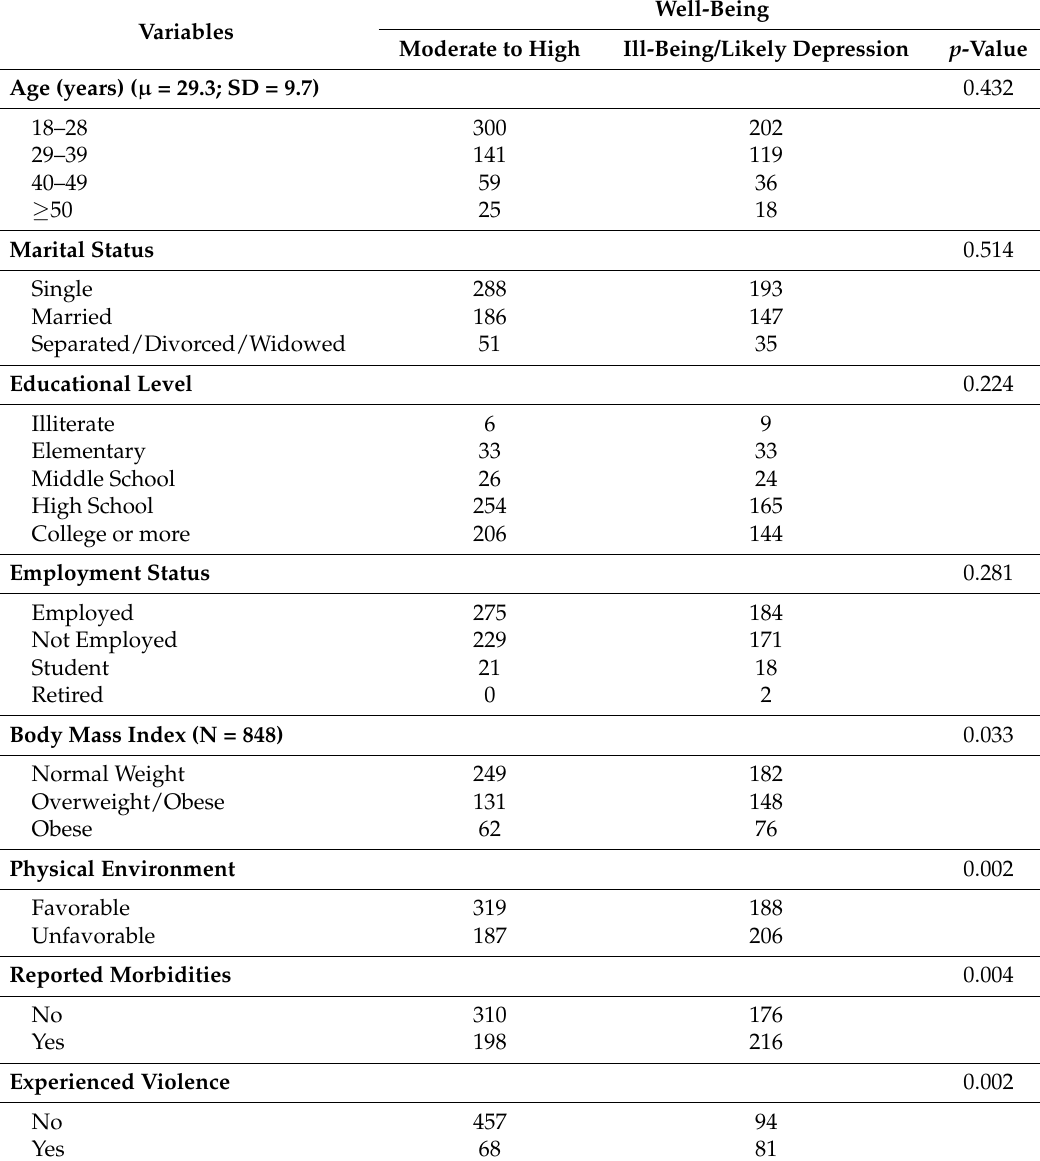
Table 2. Comparison of socioeconomic status, physical environment, lifestyle factors, and health status between women with good and poor self-rated heath (N = 900). Well-Being Variables Moderate to High Ill-Being/Likely Depression p -Value Age (years) ( µ = 29.3; SD = 9.7)